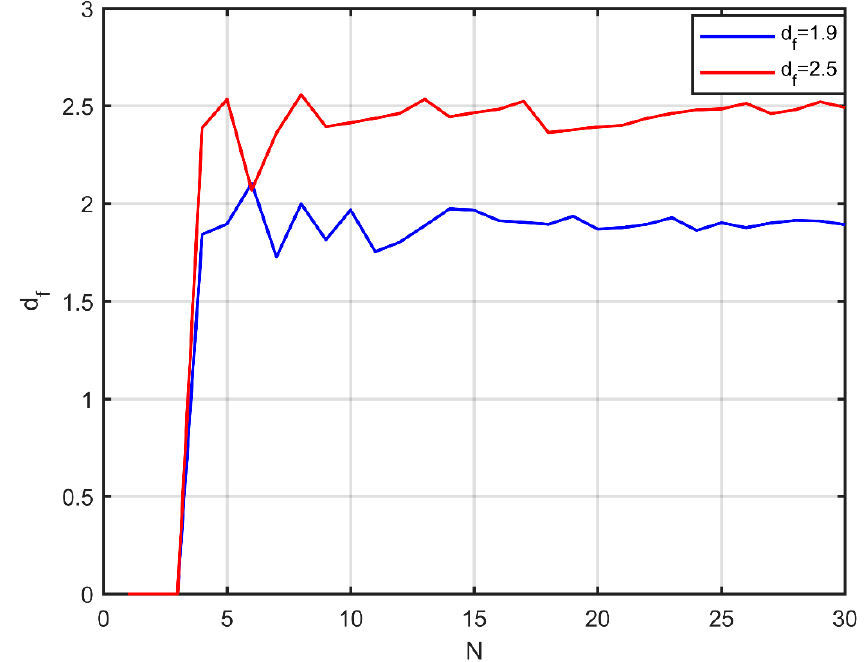
Figure 2. Evolution of the fractal dimension during aggregate formation using the proposed method, for two different fractal dimension values.